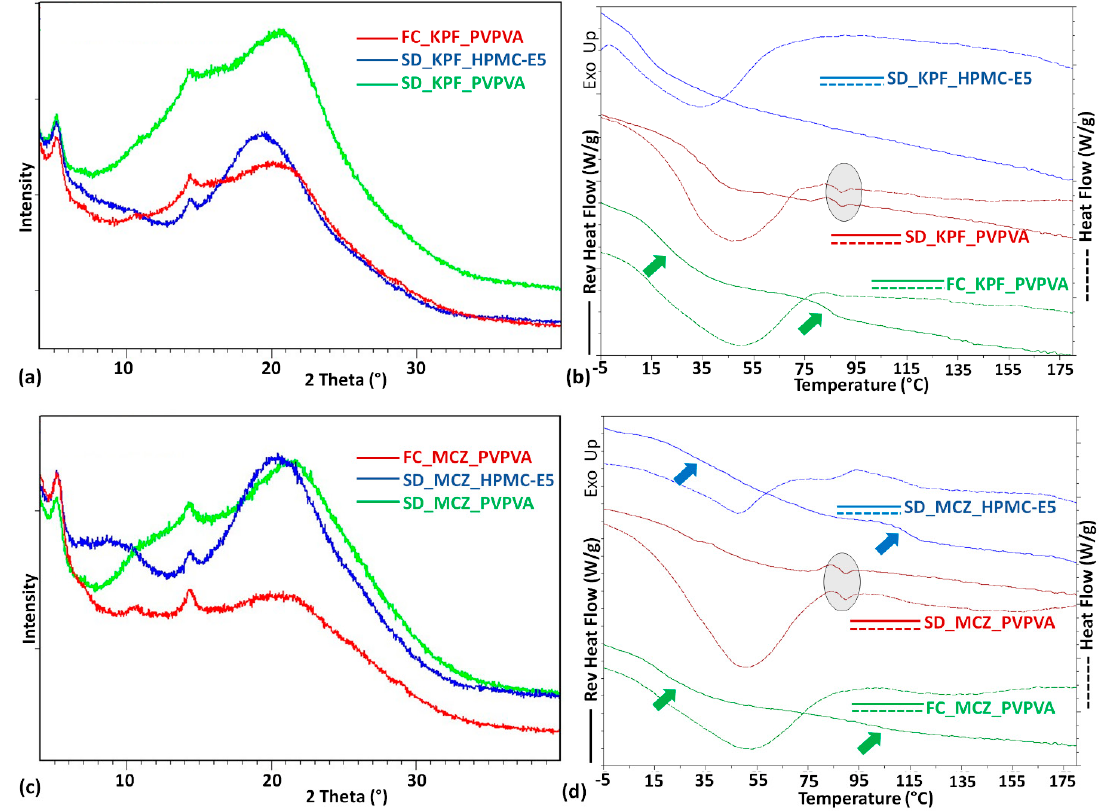
Figure 5. Overlay of PXRD patterns and mDSC thermograms of different ASDs samples of ( a )–( b ) Ketoprofen and ( c )–( d ) Miconazole. More than one T g event is marked by arrows in the mDSC thermograms. The endothermic peak of melting events is marked by the shaded ellipsoid. Solid dispersions of KPF with three hydrophilic polymers, namely, polyvinylpyrrrolidone (PVP)